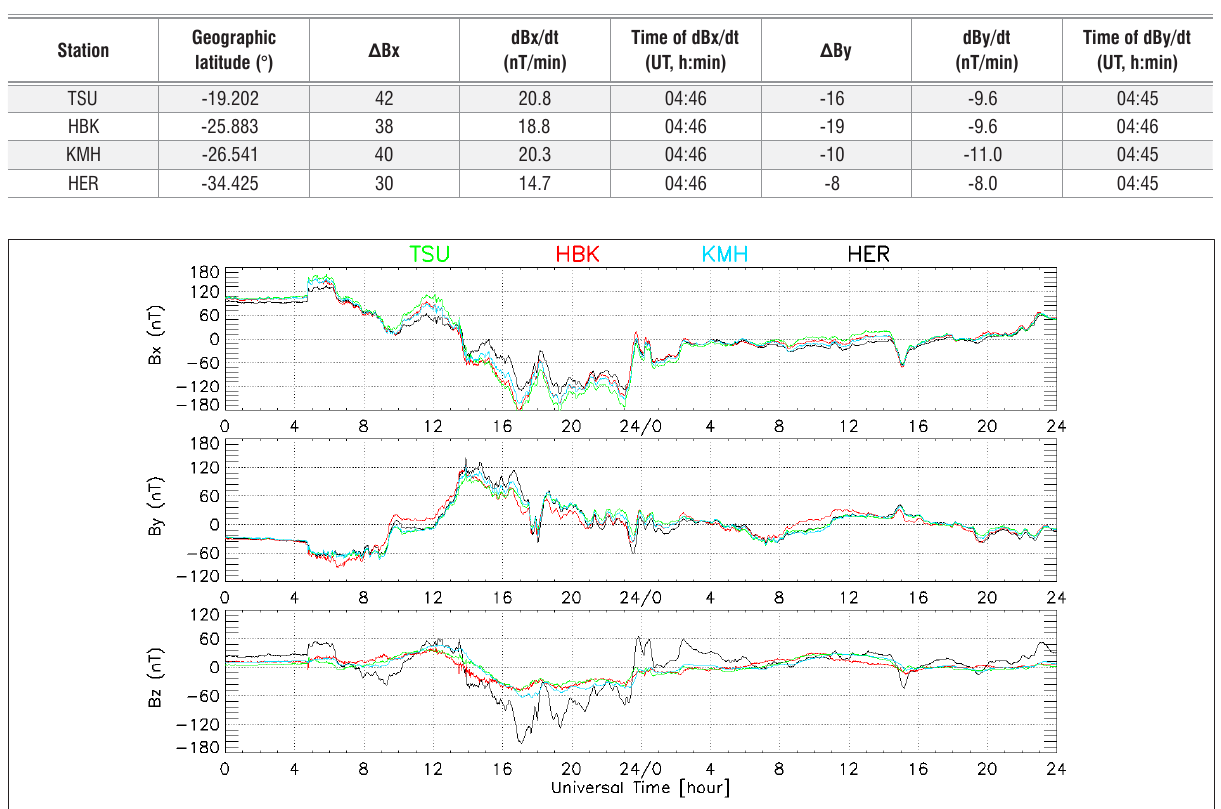
Figure 5: Plots of 1-min data magnetograms recorded during the Saint Patrick’s Day storm, 17–18 March 2015, at the four INTERMAGNET observatories (HER, HBK, TSU and KMH) managed by SANSA. The mean value over the 2-day period shown was subtracted from the data at each station before